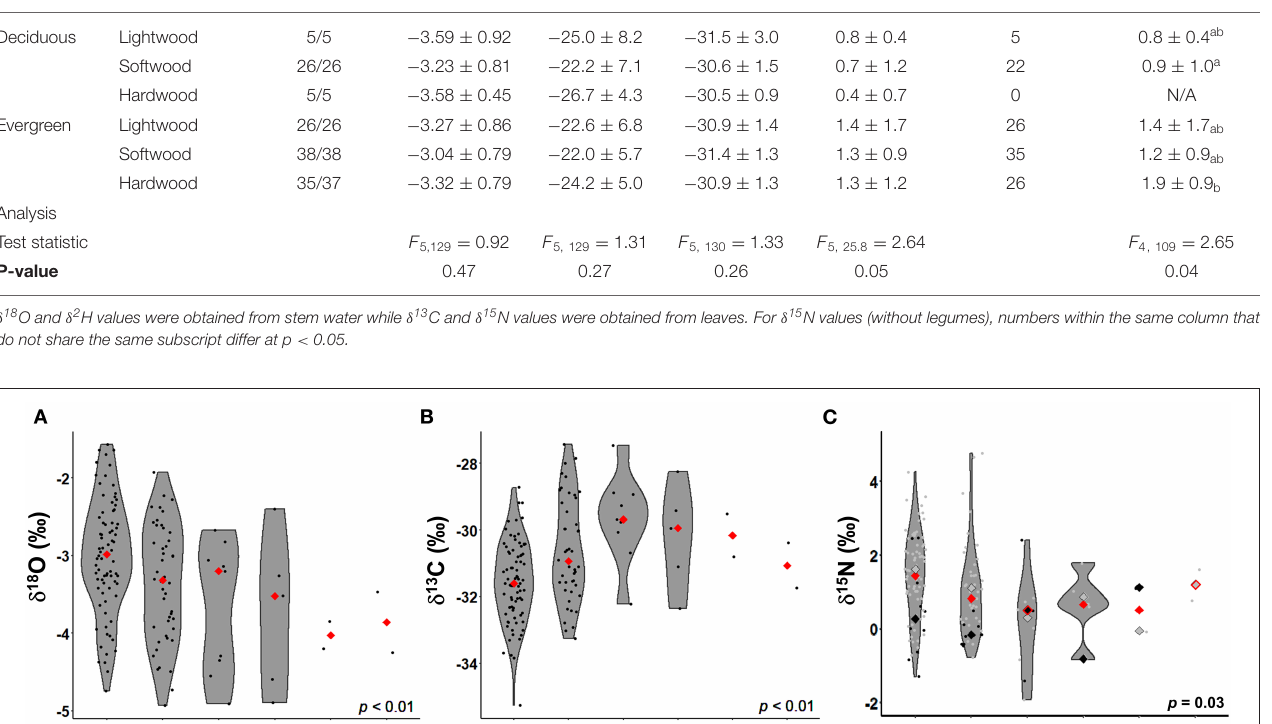
TABLE 3 | Mean and standard deviation (1 σ ) of δ 18 O, δ 2 H, δ 13 C, and δ 15 N by functional group based on leaf habit and wood density. Leaf